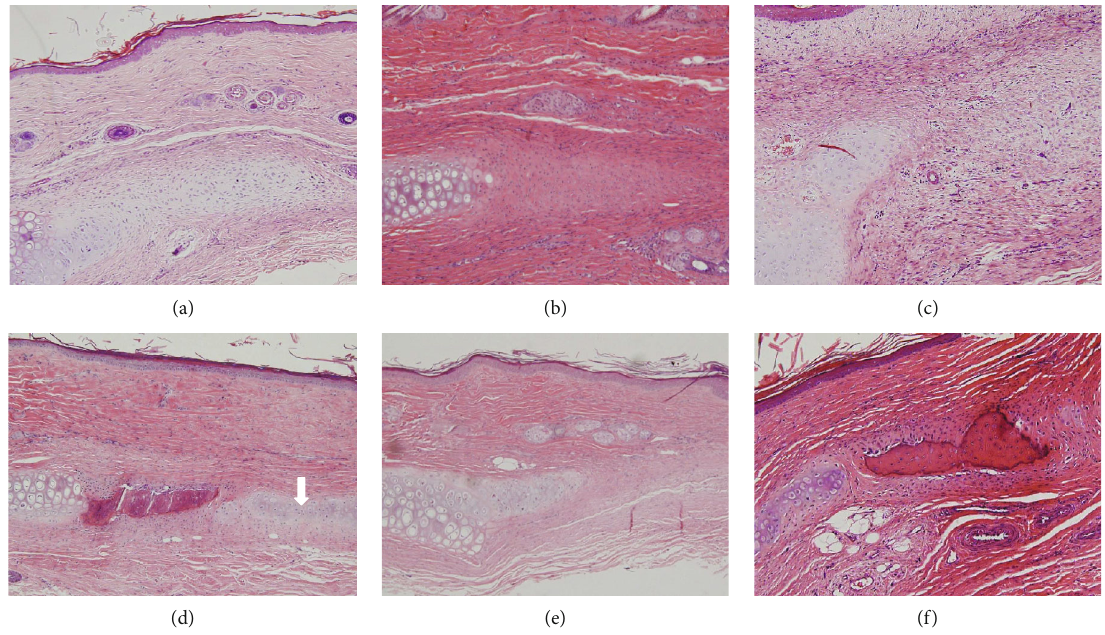
Figure 4: Histopathological features of auricular cartilage defects at 4 (a – c) and 8 (d – f) weeks after adipose-derived stromal cell (ADSC) injection. Chondroblasts and cartilage-speci fi c extracellular matrix (ECM) were evident in the ADSC group (a). ECM was deposited in the secretome group (b), and fi brous tissue formation was apparent in the PBS group (c). Typical cartilaginous features (chondrocytes, chondroblasts, and cartilage-speci fi c ECM (arrow)) were observed in the ADSC group (d). Small numbers of chondroblasts and a little collagenous tissue were evident at the defect edges of the secretome (e) and PBS groups (f), respectively. The sections were stained with hematoxylin and eosin (magni fi cation